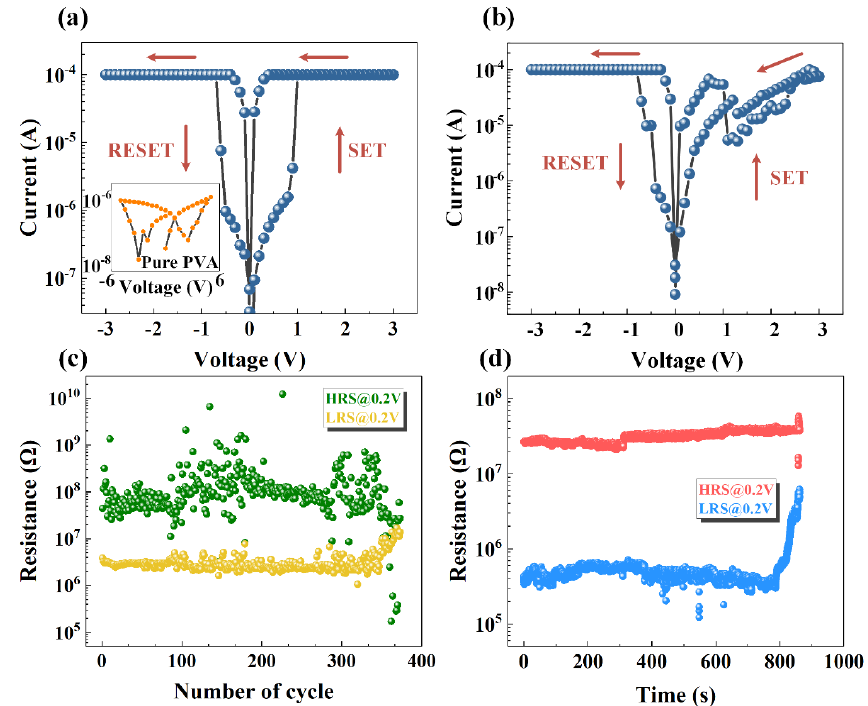
Figure 2. The I – V curve and switching behaviors of ( a ) Ag/PVA: MoS 2 /ITO, PVA: MoS 2 = 4:1, insect: Ag/PVA/ITO, ( b ) Ag/PVA: MoS 2 /ITO, PVA: MoS 2 = 4:3. ( c ) The endurance of PVA: MoS 2 = 4:1 RRAM, ( d ) The resistive-state retention time of HRS and LRS of Ag/PVA: MoS 2 /ITO, PVA: MoS 2 = 4:1.